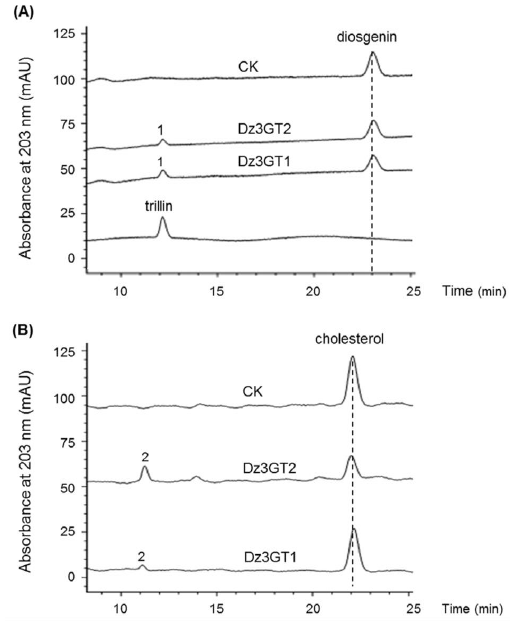
Figure 4. In vitro C3-glycosylation of diosgenin and cholesterol by the purified recombinant Dz3GT1 and Dz3GT2. HPLC profiles were shown for the assays with diosgenin (A) and cholesterol (B). CK means the control reaction. For the controls, the purified Dz3GTs were excluded from the reaction mixtures. Both Dz3GT1 and Dz3GT2 were able to convert diosgenin to one new product (peak 1), corresponding to trillin (diosgenin 3-O-glucoside), which was not produced in the controls. When cholesterol was used as the substrate, a new product (peak2) was produced by both the UDP- glycosyltransferase (UGT) proteins but was not observed from the control assays. The peak 2 was assumed to be cholesterol 3- O -glucoside based on the C3-glucosylating activities of Dz3GTs.